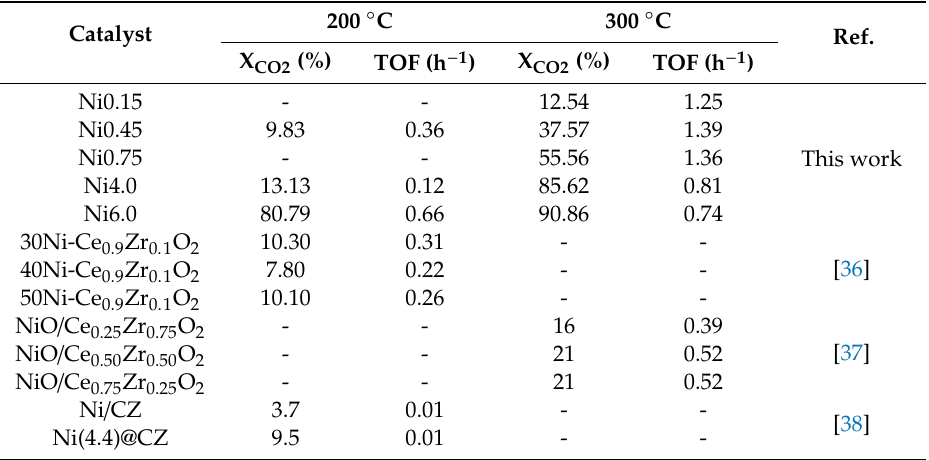
Table 2. Summary of the reaction results of CO 2